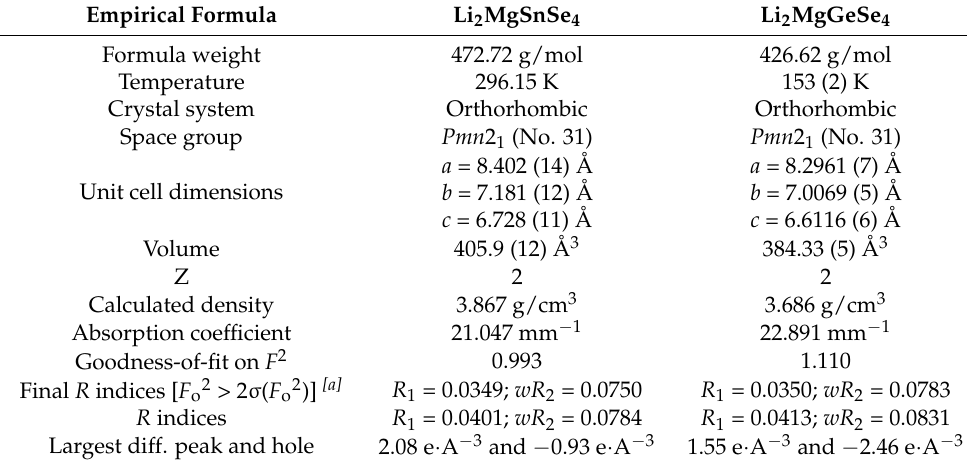
Table 1. Crystal data and structural refinements of Li 2 MgSnSe 4 and Li 2 MgGeSe 4 . Empirical